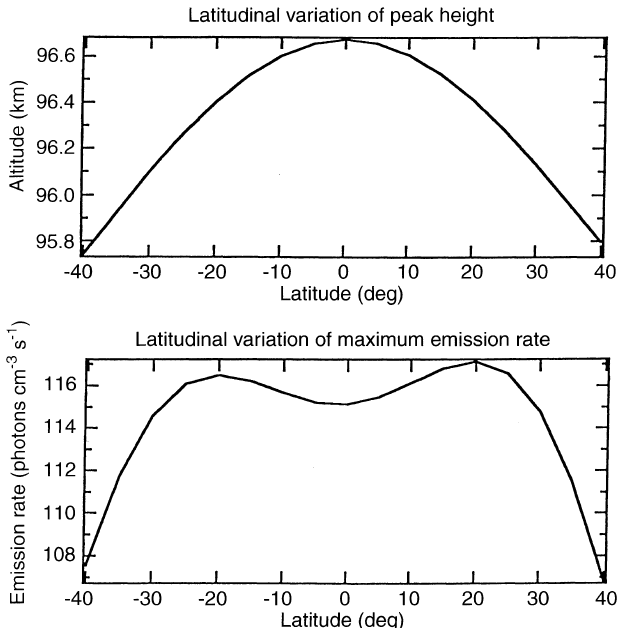
Fig. 12. Calculation from MSIS90 of the green-line emission as a function of latitude. The top panel shows the altitude of the maximum emission rate, whose value is displayed in the lower